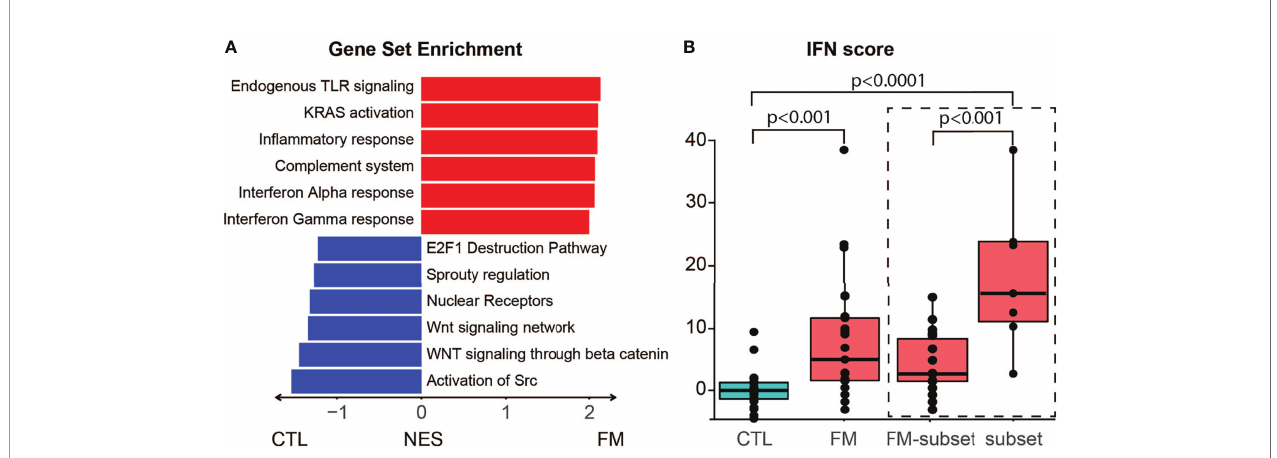
FIGURE 2 | Gene enrichment analysis and IFN score in B-cells of FM patients. (A) Differentially expressed genes predict interference with speci fi c pathways. Top upregulated pathways in FM patients comprise TLR signaling, KRAS activation, in fl ammatory response, complement system, interferon alpha and gamma response. (B) The group of 25 FM patients show a higher IFN score when compared to the 23 control individuals (p=4.13x10 -4 ). The high in fl ammatory subset of seven FM patients (subset) show a higher IFN score compared to both controls (p = 4.36x10 -7 ) and to the remaining FM patients (FM-subset; p = 5.24x10 -4